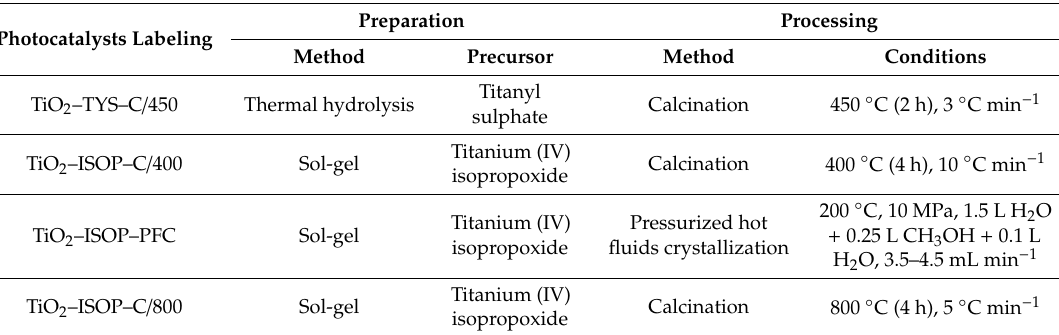
Table 3. Information about preparation of investigated TiO 2